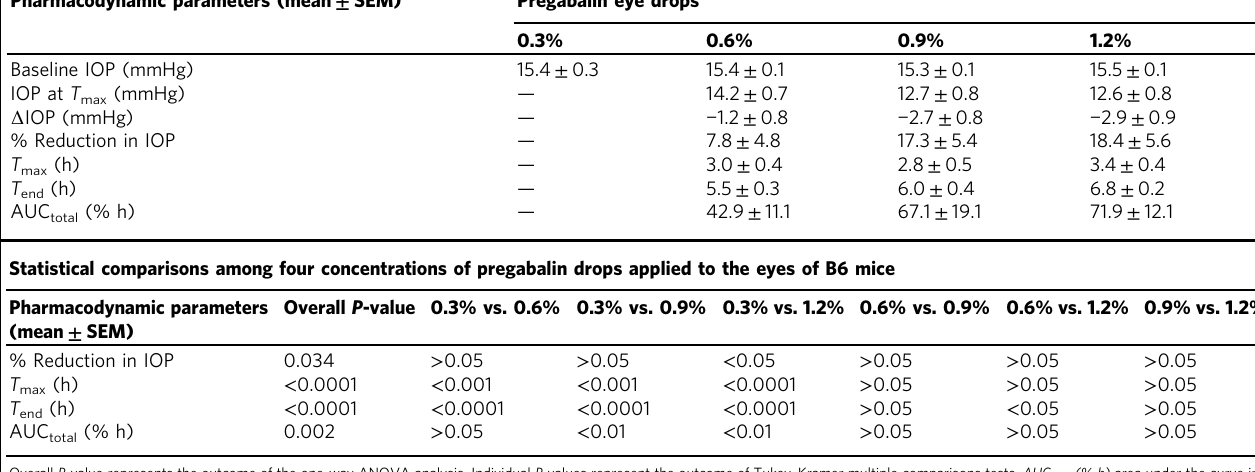
Table 1 Pharmacodynamic parameters after application of drops containing four concentrations of pregabalin to the eyes of B6 mice